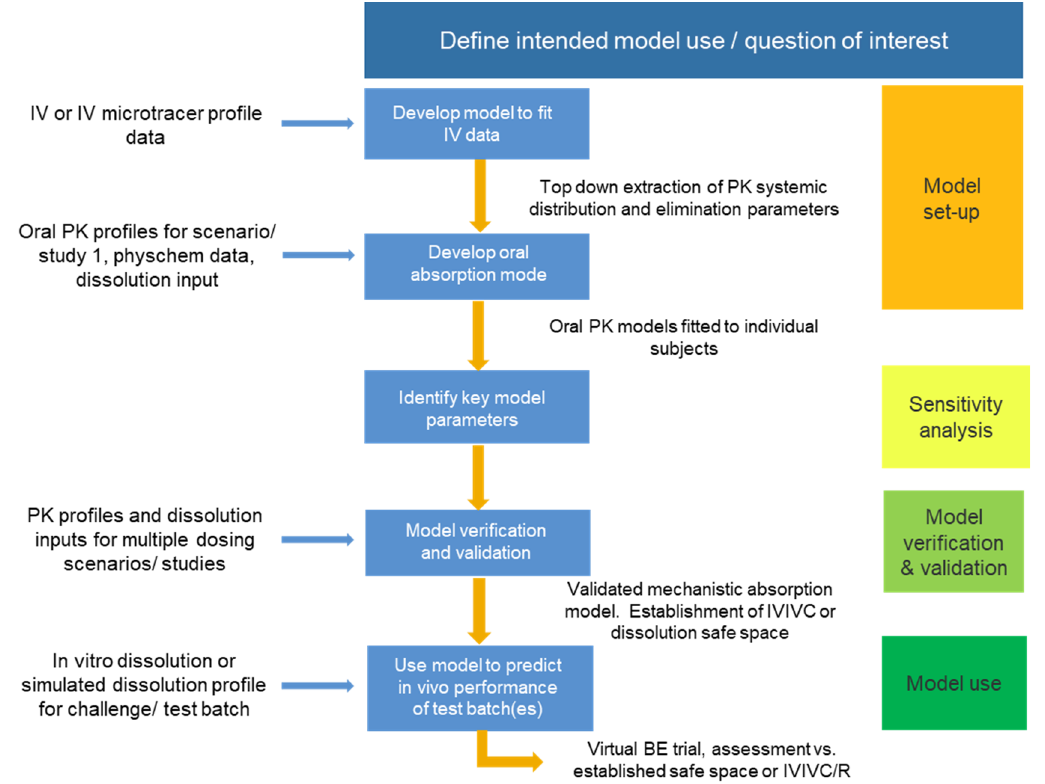
Figure 1. Schematic of approach for PBBM model development, validation, and use.